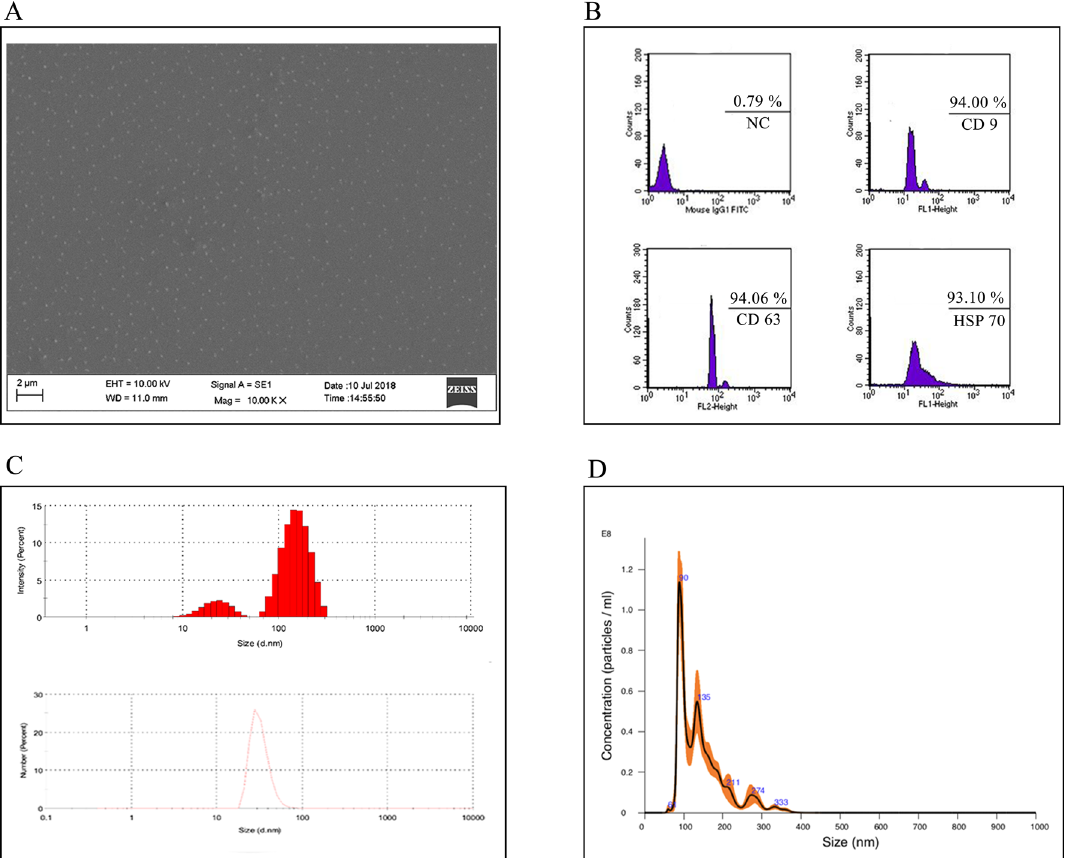
of garlic SEVs ( B ) via flow cytometry analysis with the extracellular vesicle cell surface markers against CD9, CD63, and HSP 70 antibodies. The size distribution of garlic exosomes ( C ) via dynamic light scattering